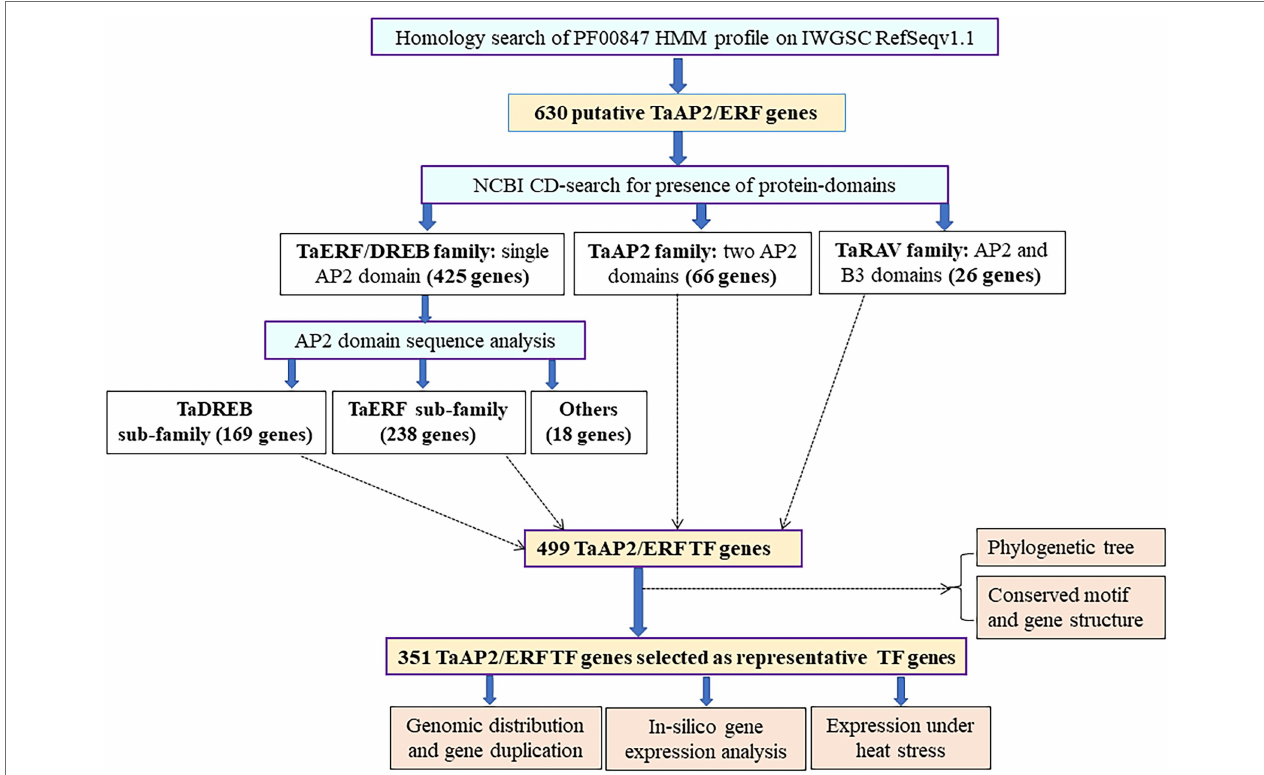
FIGURE 2 | Flowchart showing procedure followed in the TaAP2/ERF TF gene classification. The number of genes used in the major bioinformatic analysis is denoted by a bold letter inside the purple boxes with yellow background, the number of genes in gene families and sub-families are shown in bold letters in black boxes, and analysis conducted in those genes is given in black boxes with brown